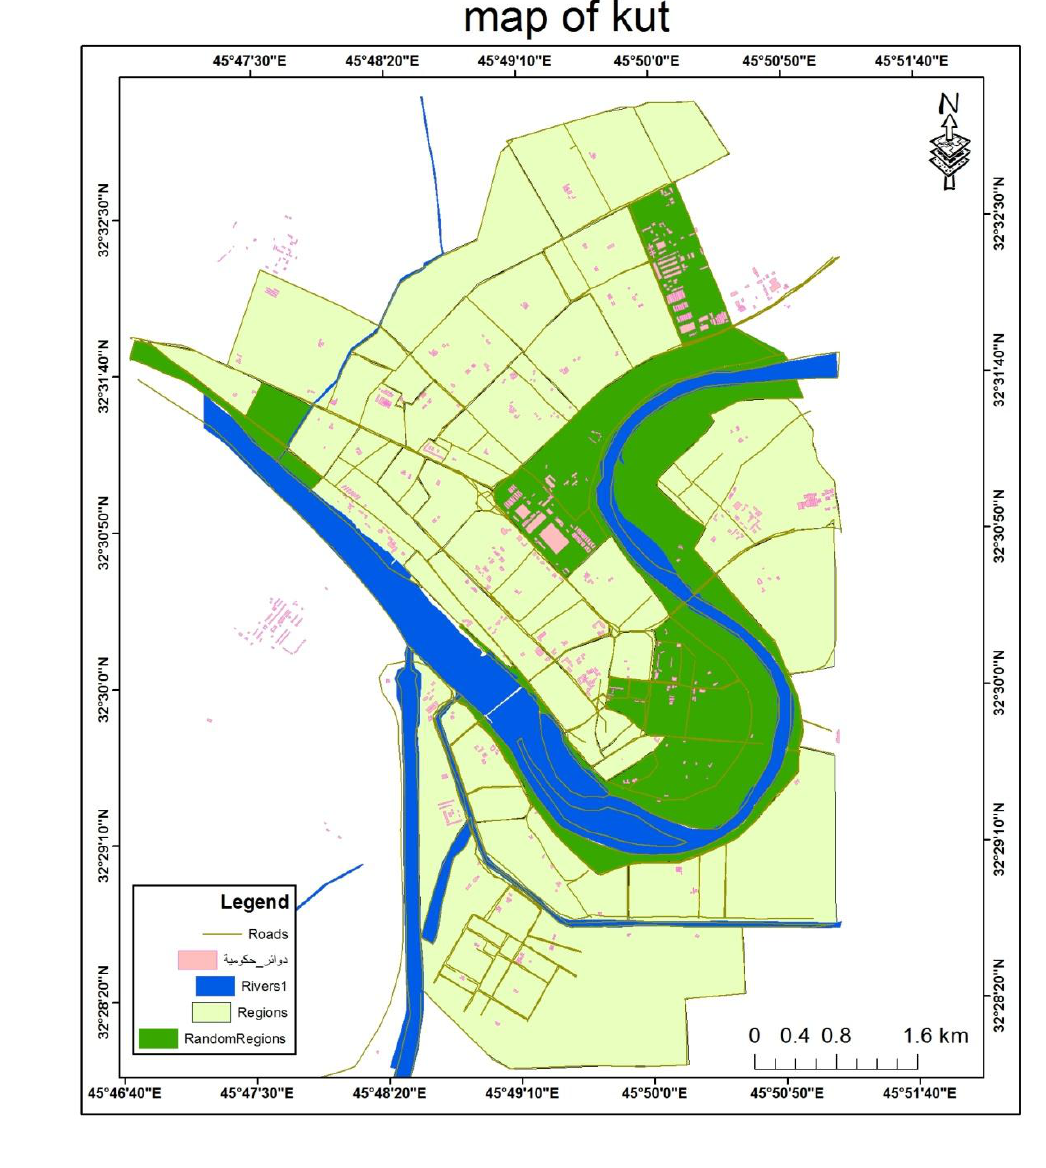
Fig.22: Producing Update map using geodatabase for Kut from high resolution satellite